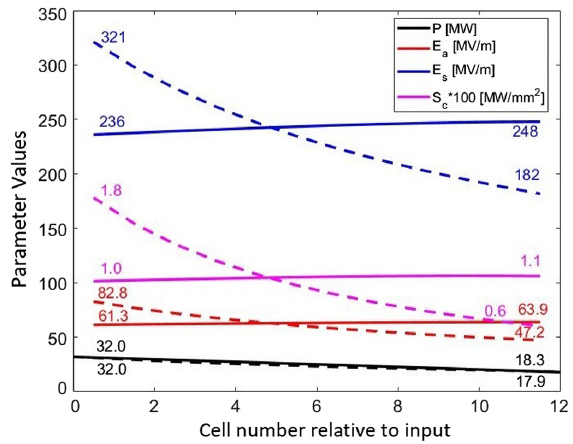
FIG. 3. Variation of the rf parameters along the structure cells at normal (solid) and backward (dash) filling with 32 MW input power; red: accelerating gradient, E ; blue: maximum surface a electric field, E ; magenta: maximum modified Poynting vector, s S ; black: input power, P . c